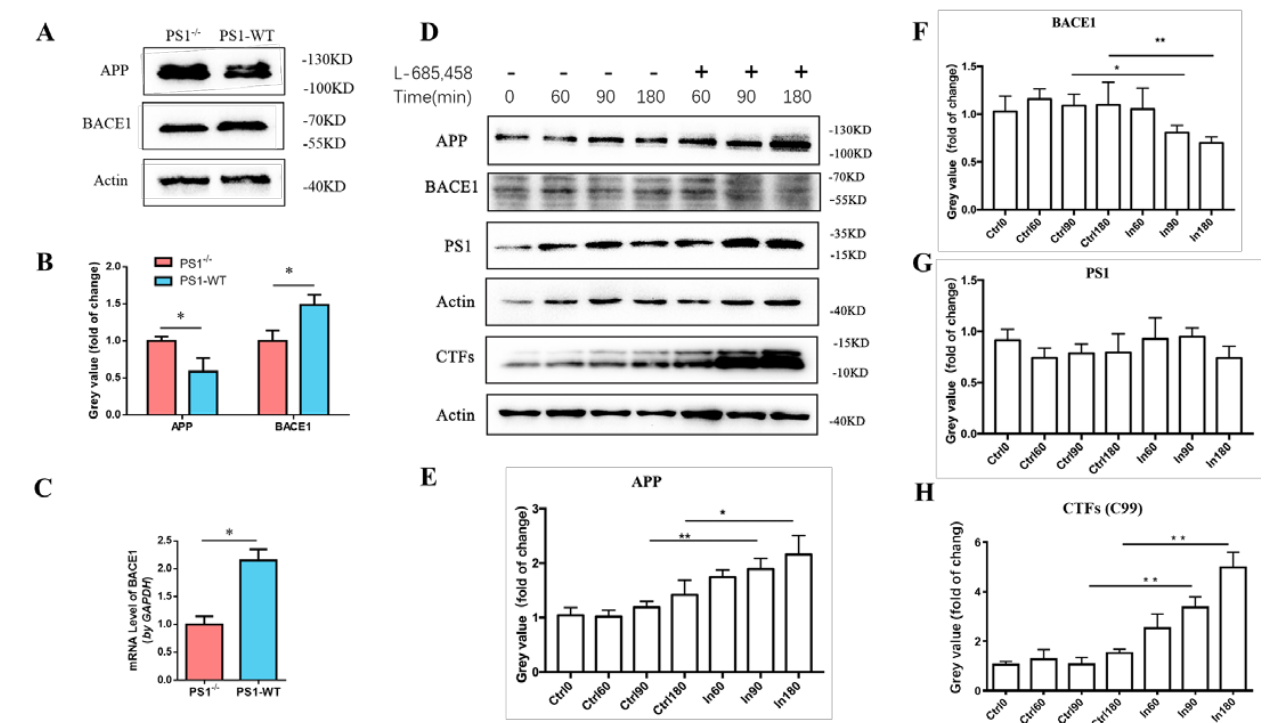
Figure 1. PS1 overexpression upregulated endogenous BACE1 in MEF PS1 − / − cells. ( A ) Western blot of the lysates 48 h after transfection with pPS1-WT or without transfection. The protein expression levels of APP and BACE1 were detected. ( B ) Quantification of APP and BACE1 in MEF PS1 − / − cells. ( C ) PS1 overexpression increased the mRNA level of BACE1 in MEF PS1 − / − cell. ( D ) Western blot of lysates from cells treated with γ -secretase inhibitor L-685,458 for 0, 60, 90, and 180 min after 48 h of transfection with pPS1-WT. The protein expression levels of APP, BACE1, PS1, and CTFs (C99) were detected. Quantification of APP ( E ), BACE1 ( F ), PS1 ( G ), and C99 ( H ); Actin was used as a reference; Dunnett’s post-hoc test: ** p < 0.01, * p < 0.05, ( n = 3).